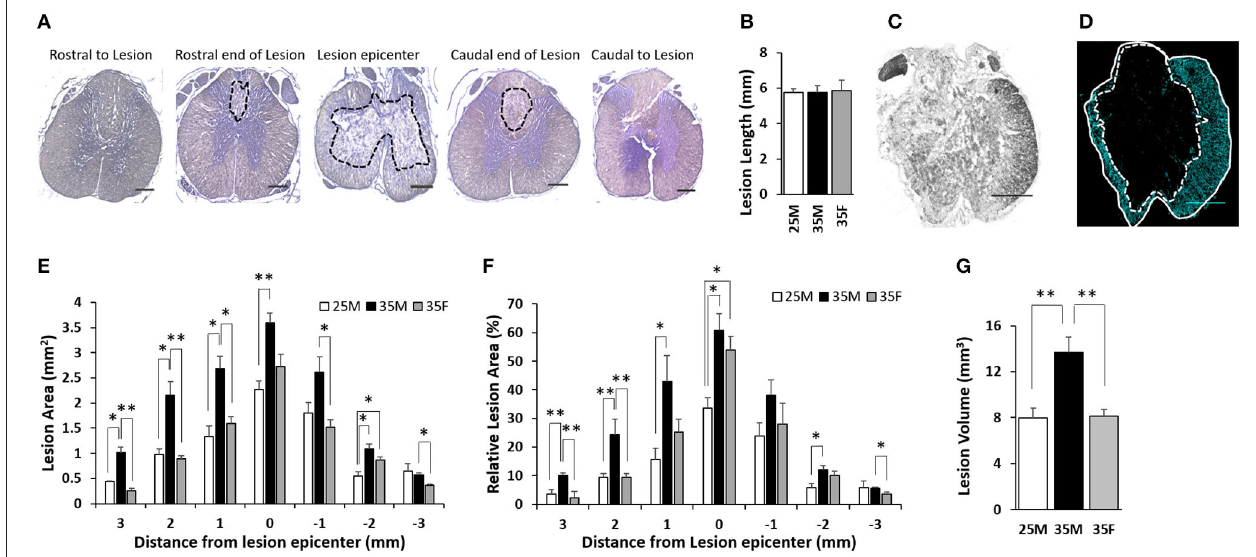
FIGURE 4 | Lesion characteristics and size following SCI. (A) Representative images of H&E staining that show the lesion epicenter, the rostral end, and the caudal ends of the lesion. Lesion areas are circled in black dashed lines. The rostral end of the lesion and the caudal end of the lesion are each 3mm rostral or caudal, respectively, from the lesion epicenter on average. Rostral to lesion and caudal to lesion are 400 µ m rostral and caudal, respectively, from the rostral end of the lesion and the caudal end of the lesion. (B) Quantification of the longitudinal length of the lesion. Data are presented as mean + SEM. (C) Bright field image of the lesion epicenter. (D) Fluorescent image of the lesion epicenter labeled for anti-glial fibrillary acidic protein (GFAP). Total tissue is circled in white line, and the lesion core is circled in white dashed line. Please see Supplementary Figure 4 for representative images of all groups at all distances. (E) Quantification of absolute lesion areas at various distances from the lesion epicenter. The lesion epicenter is recorded as 0, the distances rostral to the epicenter are in positive numbers, and the distances caudal to the epicenter are in negative numbers. Data are presented as mean + SEM (* p < 0.05, ** p < 0.01; single-factor ANOVA). (F) Quantification of relative lesion areas at various distances from the lesion epicenter. Data are presented as mean + SEM (* p < 0.05, ** p < 0.01; single-factor ANOVA). (G) Measured lesion volume. Data are presented as mean + SEM (** p < 0.01; single-factor ANOVA). Scale bar shows 500 µ